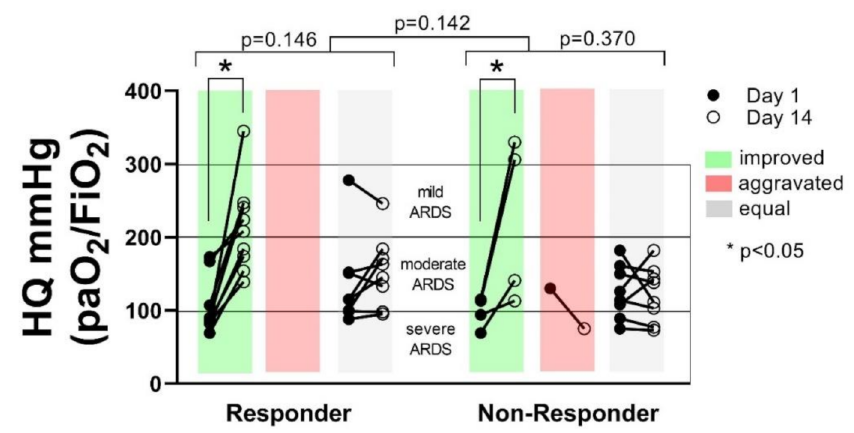
Figure 4. The number of patients changing their acute respiratory distress syndrome (ARDS) status from improved (green), aggravated (red) or equal (grey) from day 1 to day 14 was not significantly different between the groups (Responder vs. Non-Responder p = 0.142). Within the groups, the number of patients changing their ARDS status was not significantly different ( p = 0.146 vs. p = 0.370). In both groups, a significant increase of HQ in patients showing improvement from day 1 to day 14 could be shown ( p < 0.05).